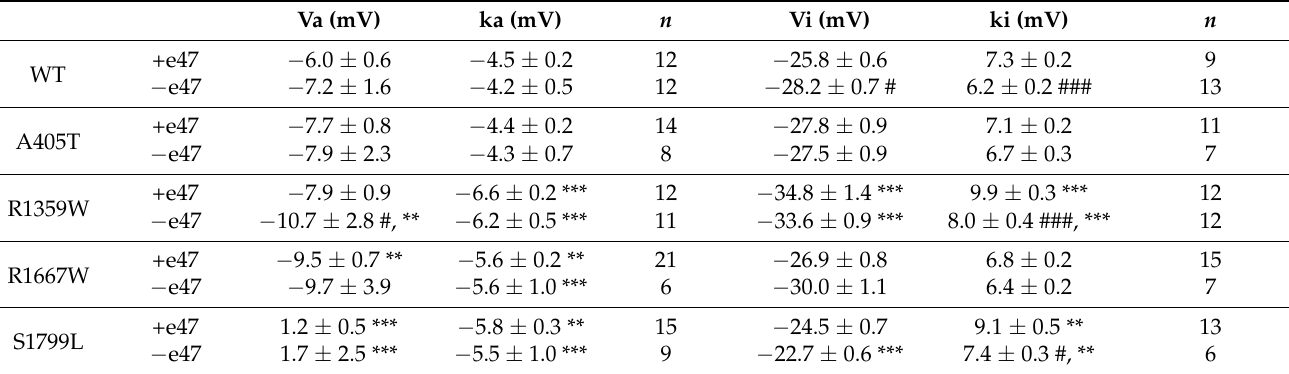
Figure 4. Voltage dependence of Cav2.1 inactivation. ( Top ) Voltage-dependent isochronal inactiva- tion curves for X. laevis oocytes expressing Cav2.1+47 ( left ) or Cav2.1−e47 ( right ) variants. ( Bottom )